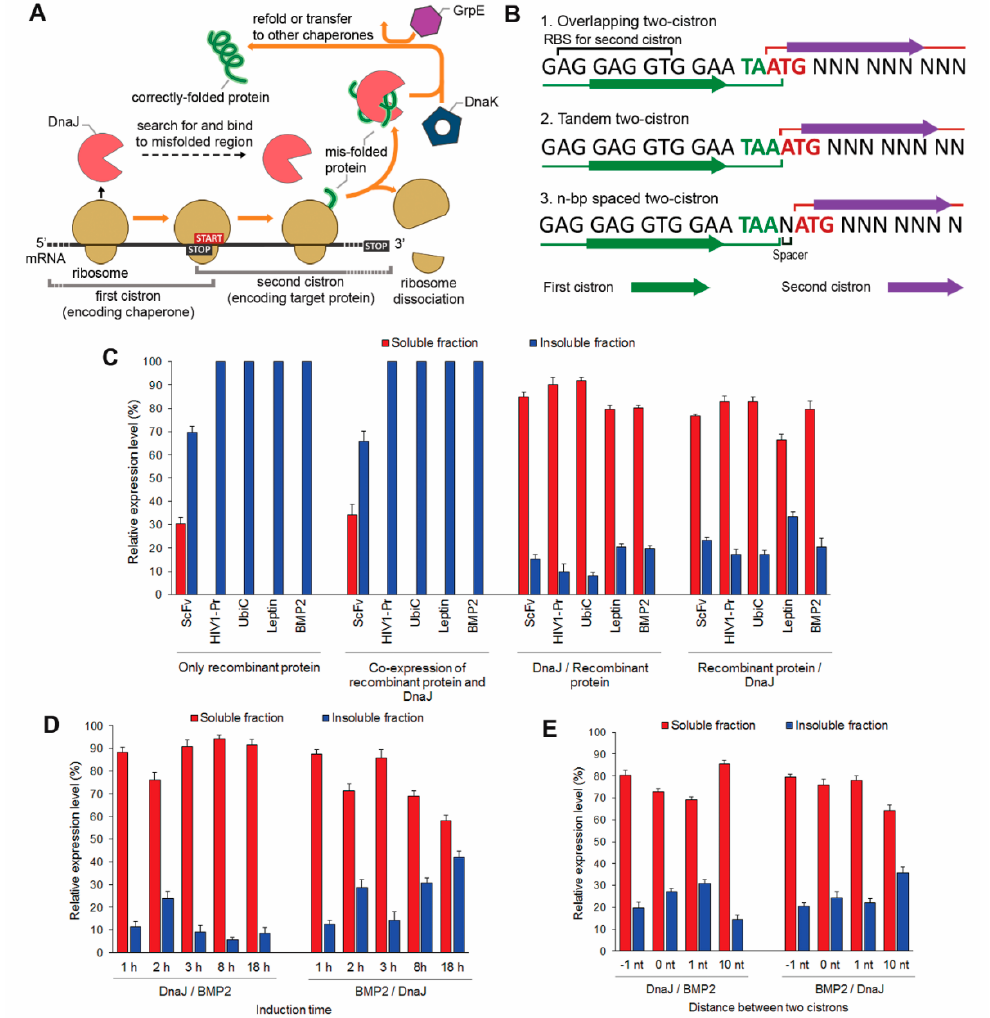
Figure 4. Recombinant protein solubilization by the CLEX system. ( A ) Schematic representation of CLEX system-mediated in vivo protein solubilization: the translationally coupled two-cistron expression system was utilized for translating DnaJ and a target protein in proximity, from a single mRNA transcript. A first cistron stop codon, TAA, is placed overlapping, in tandem, or n-nt preceding the second cistron start codon, TAG, illustrated in ( B ). In the first cistron, 6 nucleotides in the 3 ′ sequence serve as a ribosome-binding site (RBS) for the second cistron. Second cistron translation initiation involves both de novo translation and continuous translation from the first cistron. ( C ) CLEX system-mediated solubilization of five selected aggregation-prone recombinant proteins with chaperone DnaJ as the first or second cistron. Effect of DnaJ-target protein order ( D ) and distance ( E ) in the translationally coupled two-cistron expression construct were evaluated using BMP2. Slash symbols between proteins indicate the order of genes encoding each protein in the mRNA. The illustrated GrpE in ( A ) is either expressed from E. coli genome or overexpressed from a plasmid. Relative expression was assessed by SDS-PAGE and qualified using ImageJ v1.48 software. Error bars in ( C – E ) represent ± S.D. from three independent experiments.